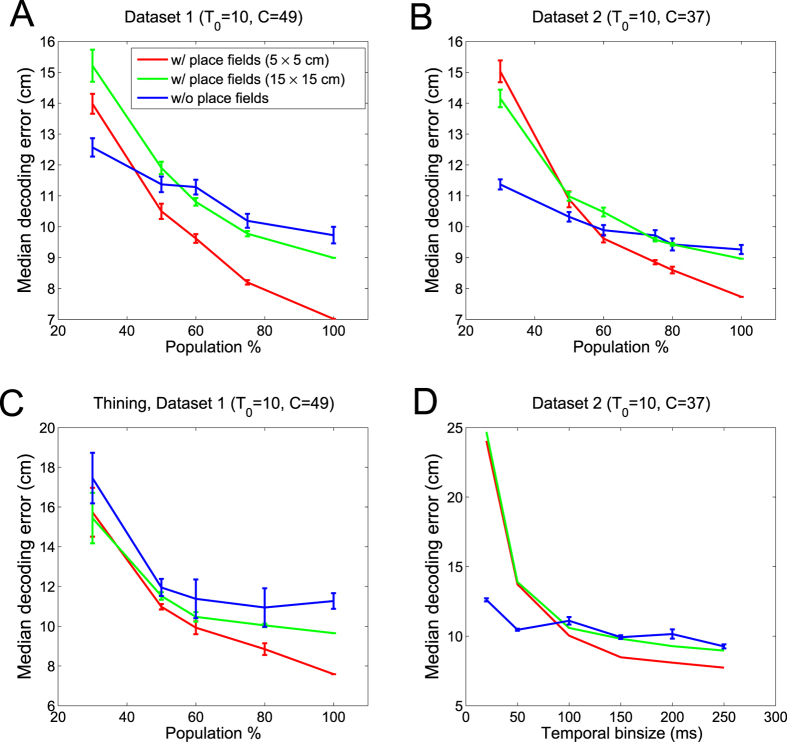
Comparison of median decoding error between DecodewRF and DecodewoRF.(A,B) Decoding error decreased with increasing numbers of cells in neuronal population. (C) Decoding error changed with respect to varying fractions of active neurons (under thinning) and (D) changed with respect to varying temporal bin size. Error bar denotes SEM (n = 50 Monte Carlo runs).